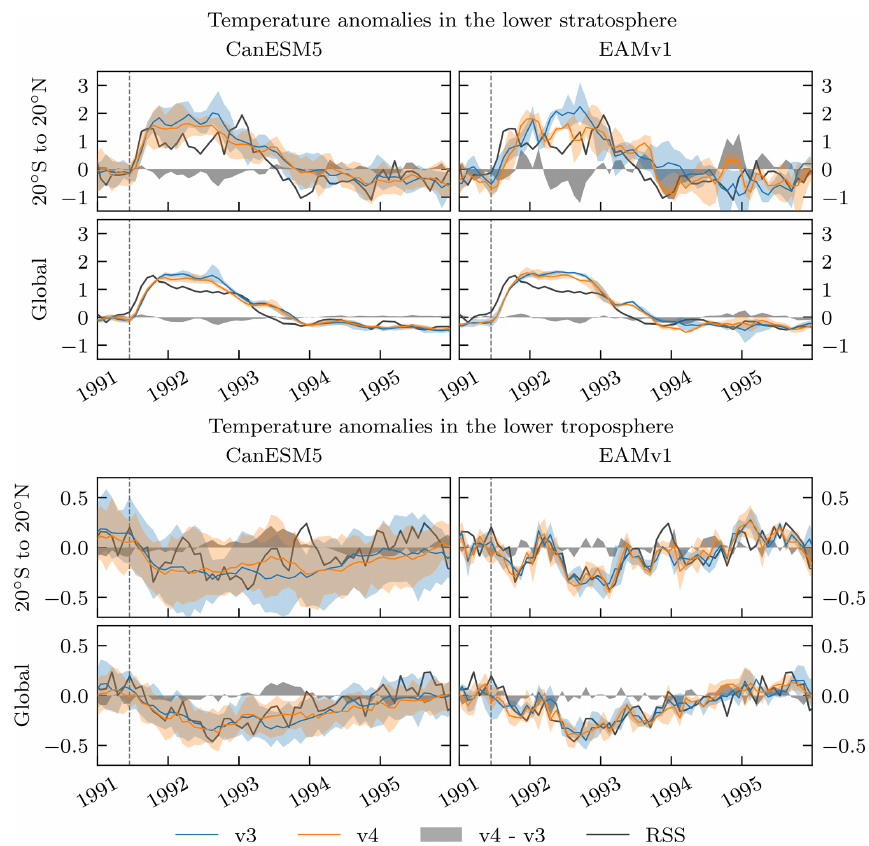
Figure 7. Temperature anomalies in the lower stratosphere (top two rows) and lower troposphere (bottom two rows) in the tropics and globally averaged. The left column shows results from CanESM5 and the right column EAMv1. Solid blue lines show the mean temperature anomaly using the version 3 dataset, and orange lines show the same using version 4. The blue and orange shaded regions show the 10th and 90th percentiles for version 3 and 4 respectively for the CanESM5 ensemble and the max–min range for the EAMv1 ensemble. The gray region shows the mean difference between simulations using version 3 and version 4. The black line shows the Remote Sensing Systems (RSS) observations, and the dashed line marks the eruption of Pinatubo on 15 June 1991. Anomalies are computed using the simulation period of